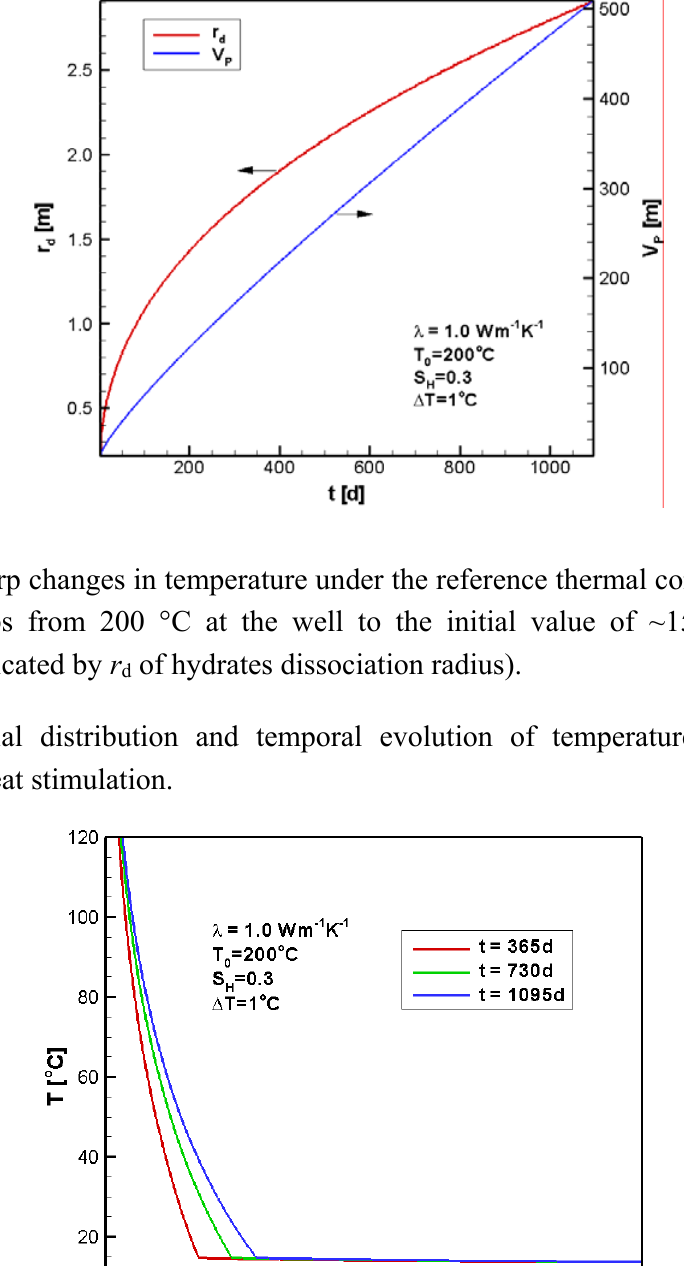
and cumulative gas production V d